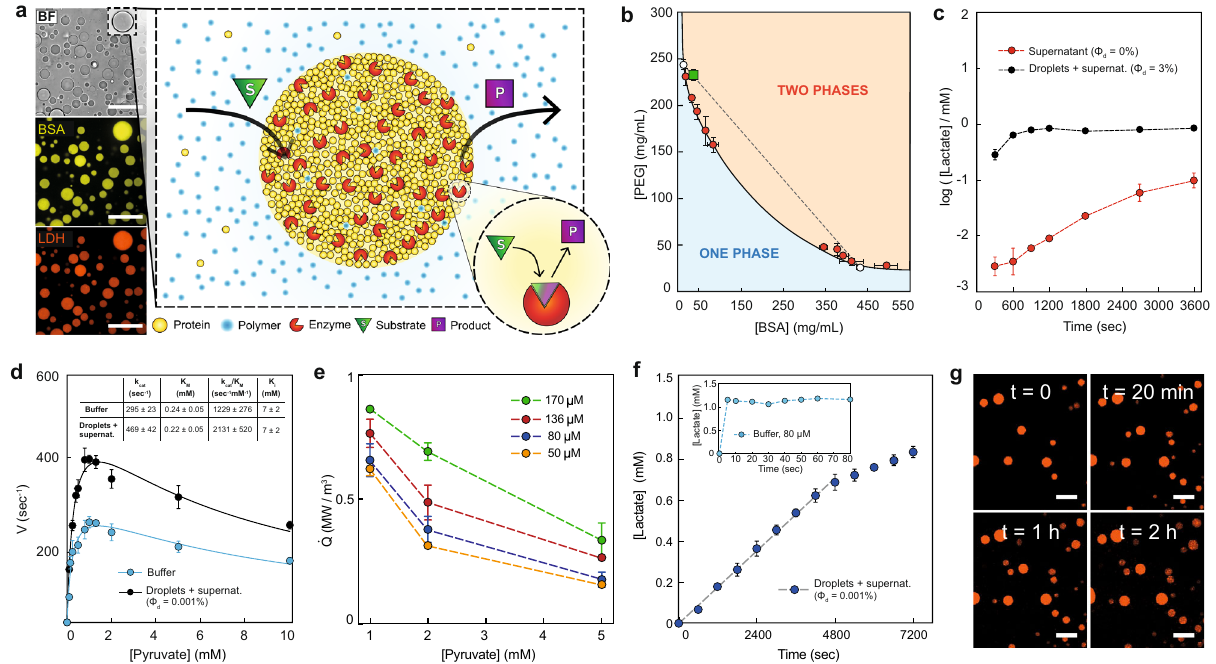
Fig. 1 Liquid-liquid phase separation of BSA droplets and LDH metabolic activity. a Schematic representation of a general active liquid-liquid phase- separated protein droplet system with partitioned enzyme, by the action of a crowding polymer. The substrate is present in the continuous phase and can freely diffuse inside the droplets, while the product formation catalyzed by the enzyme in the droplet phase can diffuse out. The relative concentrations are not drawn to scale. Left side: confocal microscopy images of droplets with labeled protein (BSA) and enzyme (LDH). Top to bottom: bright- fi eld channel, fl uorescent BSA, and LDH channels. Confocal images were acquired for more than 20 independent experiments with similar results. b Phase diagram of the PEG-BSA phase-separated droplets. The green square denotes the overall composition of the droplet suspension at the chosen working condition. White circles represent the compositions of the two phases at the working condition. The dashed line indicates tie line connecting these two compositions. Data are represented as mean values ± standard deviation (SD) from three independent experiments ( n = 3). c Lactate production in a ϕ = 3% dispersion of droplets in the supernatant with an LDH concentration of 0.060 μ M in the droplets in the presence of 1 mM pyruvate and 2 mM NADH (black) and in the same system after the droplet phase was removed by centrifugation (red). See SI for the calculation of enzyme concentration inside the droplets. Data are represented as mean values ± SD from three independent experiments ( n = 3). d Velocity values at different pyruvate concentrations of droplets containing 3.3 μ M LDH, dispersed in the supernatant (black) compared to that obtained in buffer using 2 nM LDH (cyan). The velocity values have been fi tted using the substrate inhibition equation 85 . Inset of panel d , kinetic parameters of droplets containing-LDH compared to those of free LDH in a buffer. The values of k K cat and M have been calculated by plotting the velocity values from 0.1 to 1.3 mM pyruvate (values without substrate inhibition) using the Michaelis – Menten equation 86 . The graph is reported in Fig. S3. Data are represented as mean values ± SD from three independent experiments ( n = 3). e Different metabolic rates obtained varying the enzyme (concentration of LDH in the droplets 50, 80, 136, and 170 μ M respectively) and substrate concentrations (1, 2, and 5 mM pyruvate) in the presence of 10 mM NADH. The volume fractions ( ϕ D ) used in these experiments and the trends of lactate production over time at different enzyme and pyruvate concentrations are reported in Fig. S4. Data are represented as mean values ± SD from three independent experiments ( n = 3). f Lactate production over time (equal to pyruvate consumption) for LDH in droplets (concentration 80 μ M inside the droplets) in presence of 5 mM NADH and 1 mM pyruvate. Inset: Lactate production over time of LDH in buffer, at a concentration equal to that in droplets (80 μ M), in the presence of 2 mM NADH and 1 mM pyruvate. g Confocal images of the droplets partitioning labeled LDH during a sustained activity at different times, at the same conditions (LDH, pyruvate, NADH concentrations, and volume fraction) as in panel f . Confocal images were acquired for more than ten independent experiments with similar results. All scale bars are 50 μ